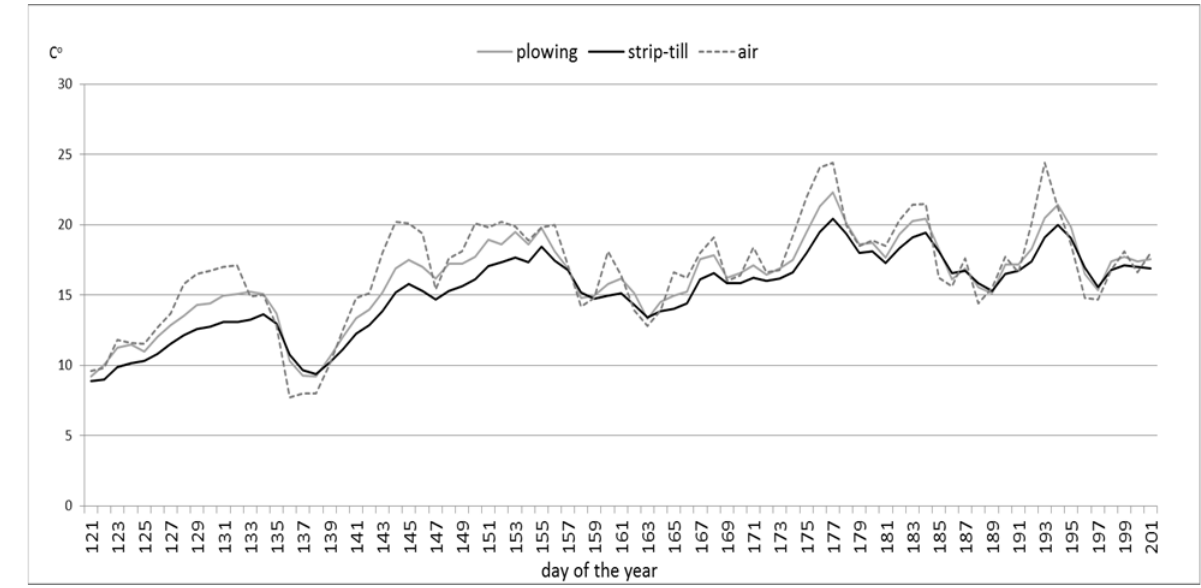
Figure 5. Dynamics of soil and air temperature (daily averages) depending on cultivation technology (ST vs. PT—average for row and inter-row) throughout the research period.